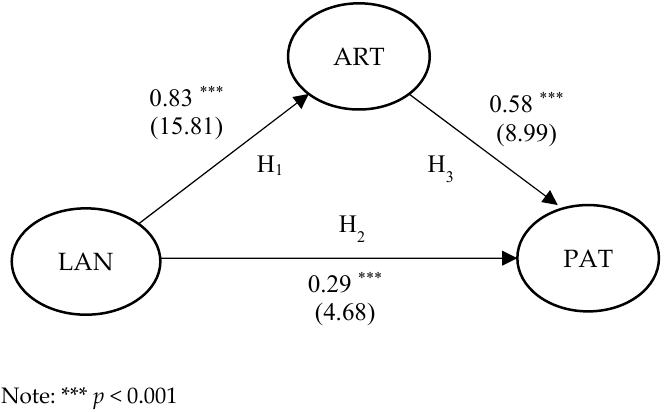
Figure 2. Path coefficients of the structural model.